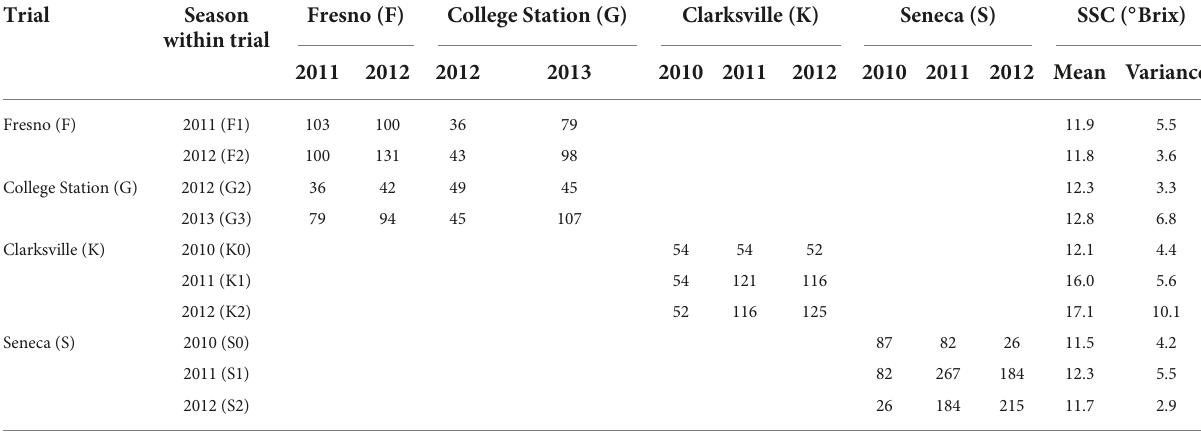
TABLE 1A Number of peach/nectarine individuals within and among ten trial-by-season environments assessed for SSC from three breeding programs (Fresno and College Station: Texas A&M University (TAMU) population, Clarksville: University of Arkansas (UARK) population; and Seneca: Clemson University (CLEM) population).